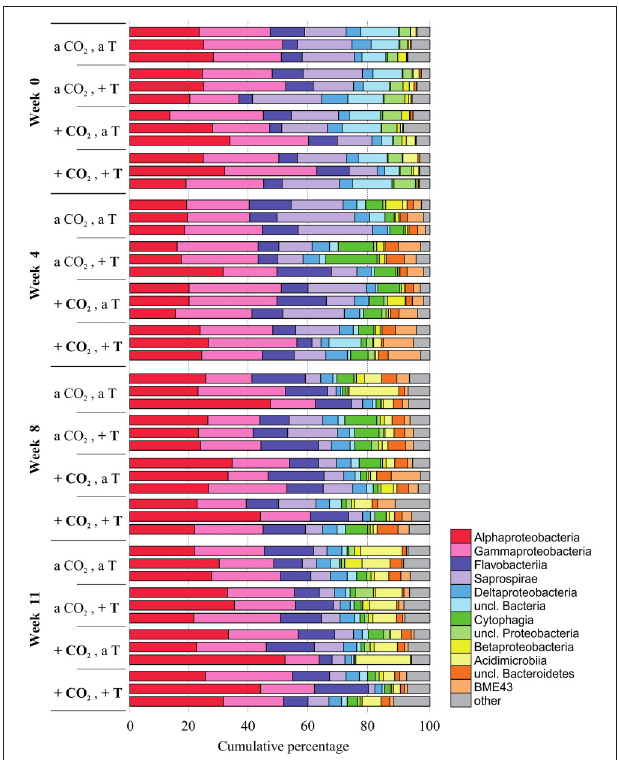
FIGURE 2 | Relative abundances (in cumulative percentage) of the most abundant epibacterial classes of Fucus mytili . Epibacterial community patterns are depicted for each sample ( n = 3 per treatment) after 0, 4, 8, and 11 weeks of treatment in the benthic mesocosms at different conditions (see Section “Materials and Methods”; a, ambient; + , increased/elevated). Analysis is based on bacterial 16S rDNA (V1–V2) MiSeq amplicon sequencing. Low abundant classes ( ≤ 1%) were summarized as “other.”